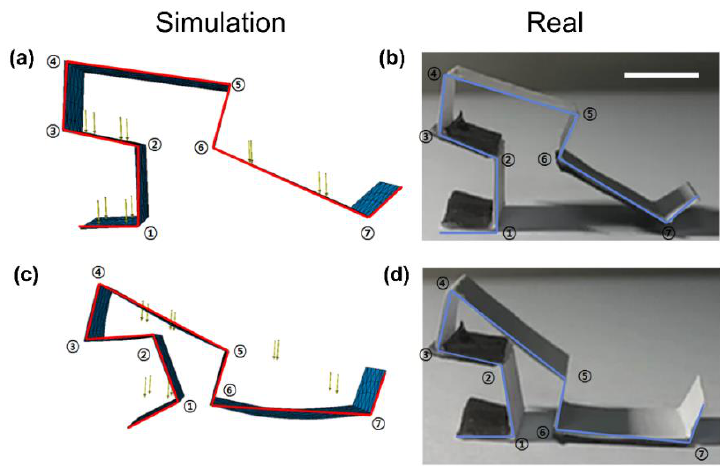
Figure 7. Numerical simulation and actual behavior. ( a – d ) The appearance of the soft robot when ( a , b ) there is no magnetic field and ( c , d ) there is magnetic field of 0.5 T. (Scale bar: 5 mm).